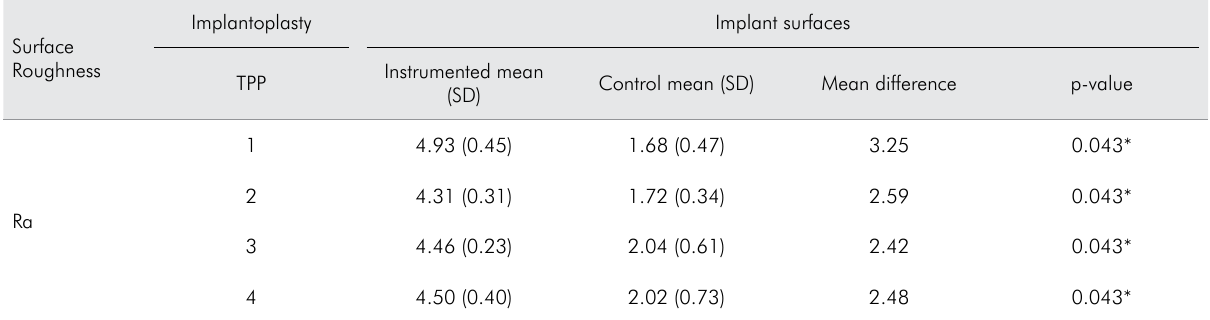
Table 1. Surface roughness averages and p-values for both instrumented and control surfaces of Moderately roughened Disks.